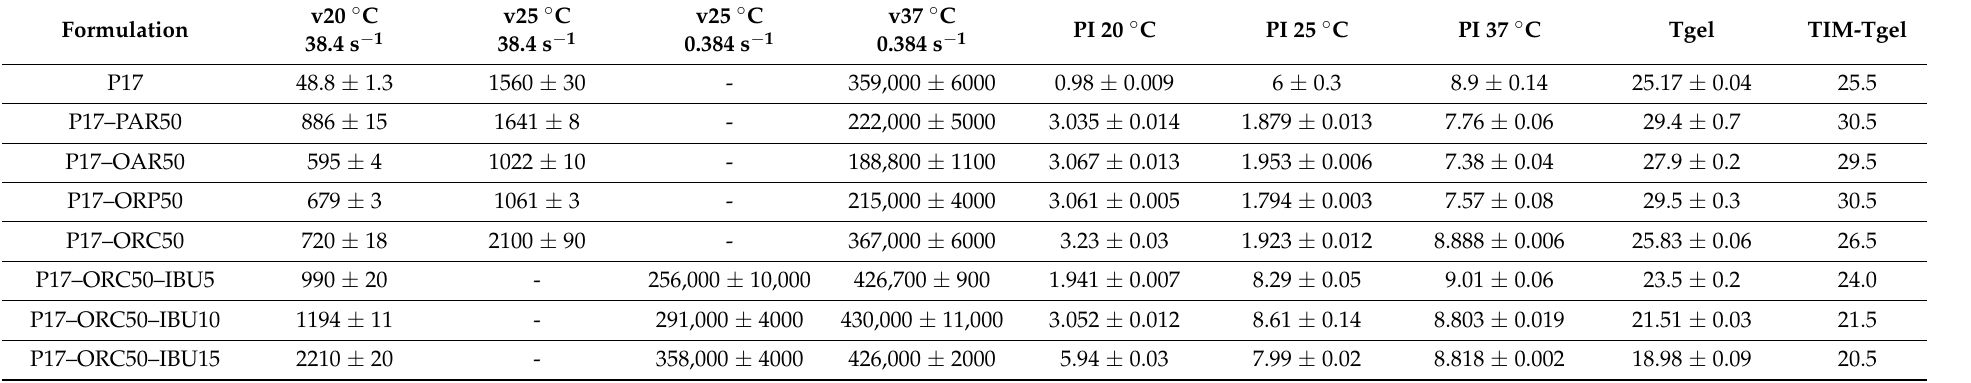
Table 3. Summary of rheological data. Means ± sd, n = 3. Viscosities (v) in mPas; Pseudoplasticity Index